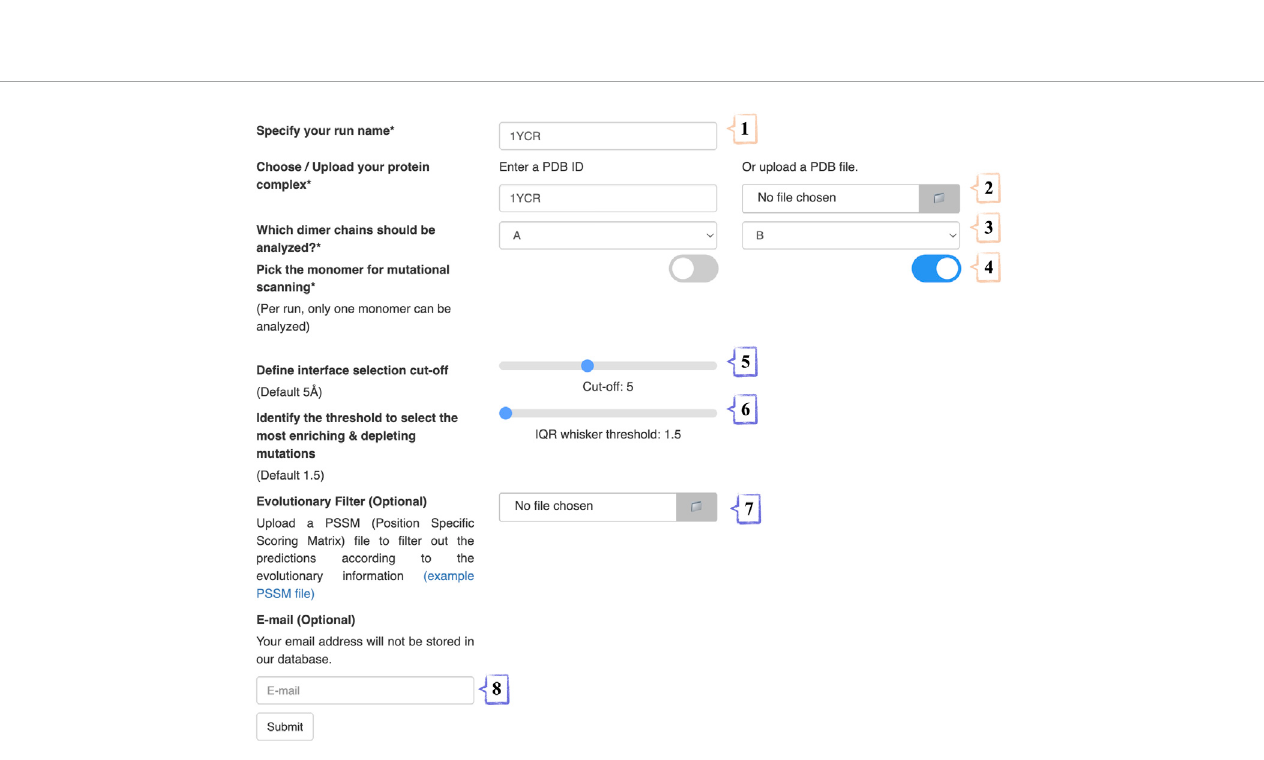
FIGURE 2 The stepwise annotation of PROT-ON run submission page with 1YCR (MDM2-p53 case) example. Wheat and slate colors represent mandatory and optional fi elds, respectively.